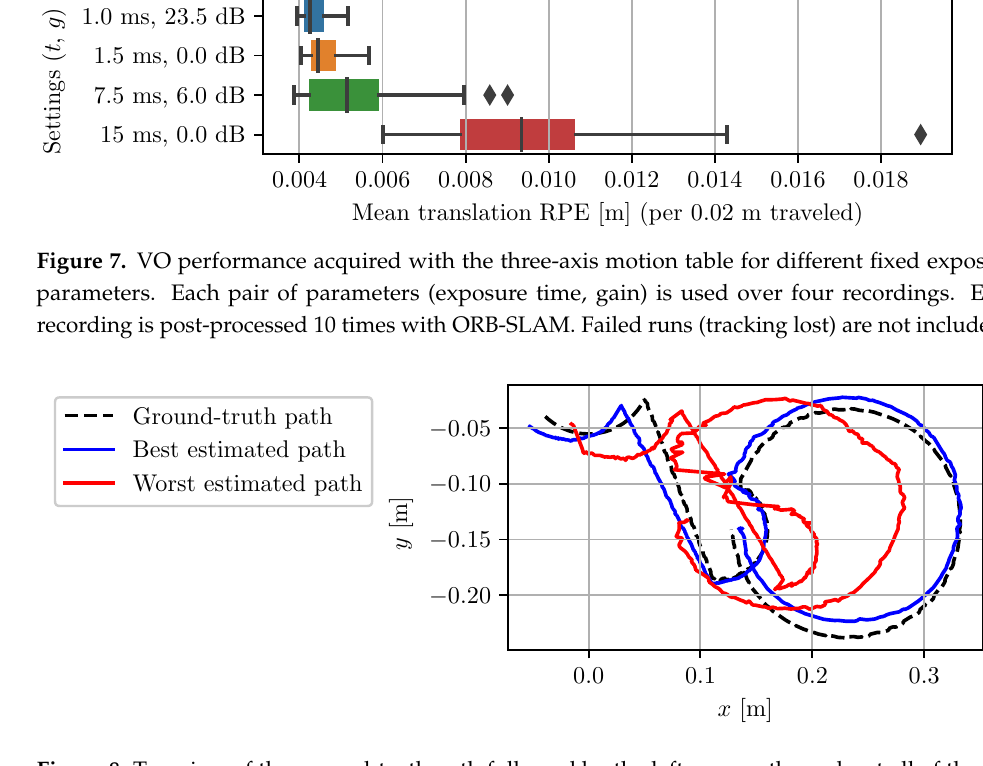
Figure 8. Top view of the ground-truth path followed by the left camera throughout all of the test sequences. The best and worst paths estimated by ORB-SLAM3 are overlaid for